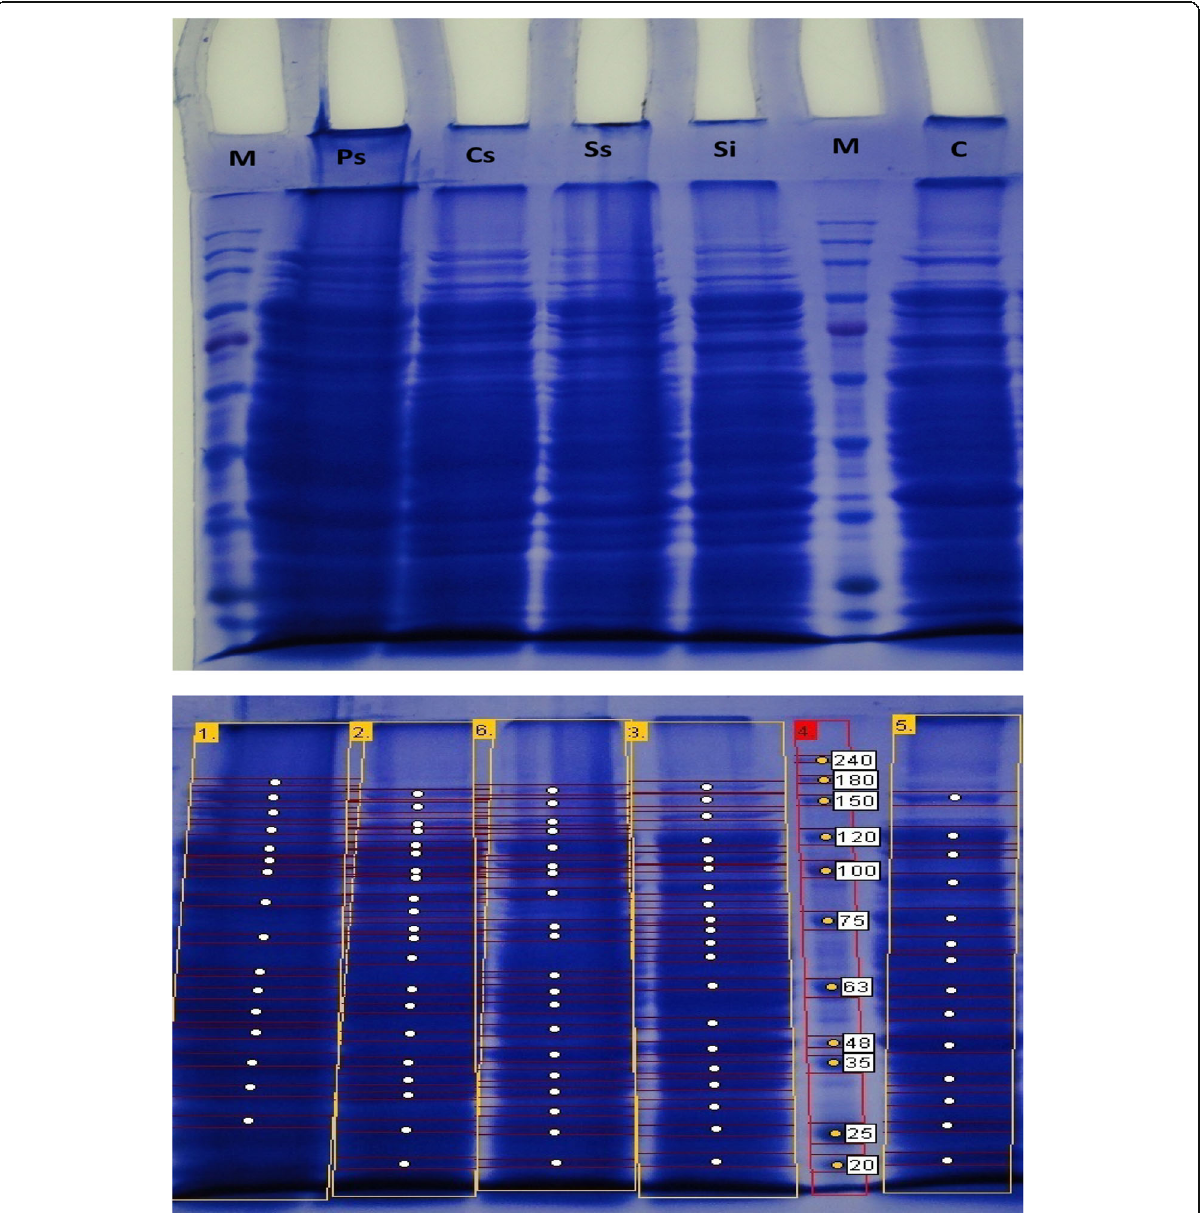
Fig. 1 Protein patterns of strawberry plants as affected with silicon and silicate salts. Upper patterns: Ps = potassium silicate, Cs = calcium silicate, Ss = sodium silicate, Si = silicon, C = Control, M = marker; Lower patterns: 1 = potassium silicate, 2 = calcium silicate, 3 = sodium silicate, 4 = marker, 5 = Control, 6 =